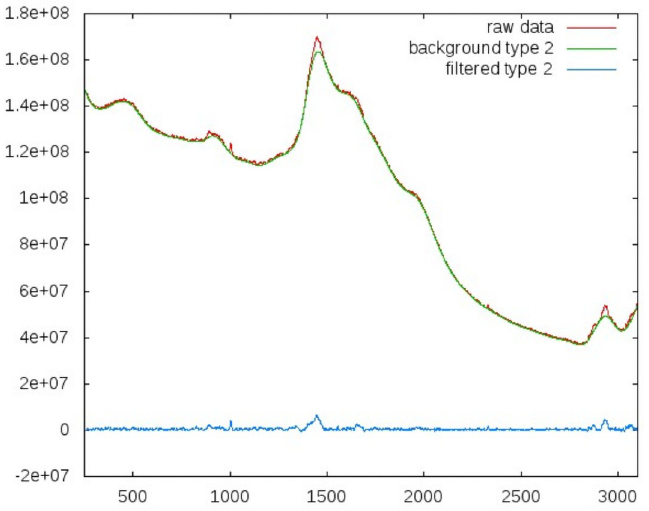
Fig 4. Background filtering with a more ‘flexible’ smoothing curve, leading to stronger filtering. Red indicates the original spectra, green the smoothing functions, blue the filtered data.